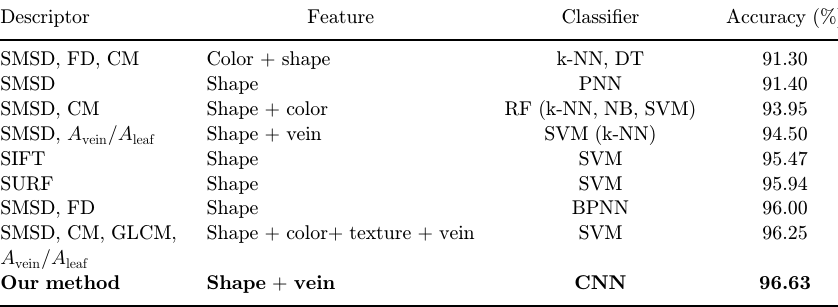
Table 5. Comparison results of leaves recognition methods on the Flavia data set.